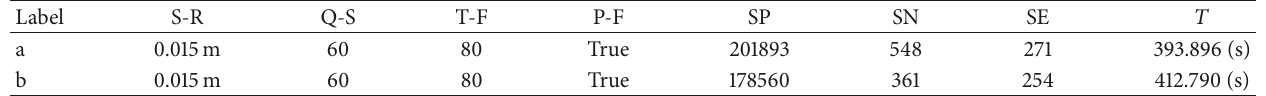
Table 2: Parameters and results of the proposed method and the shortest path method.